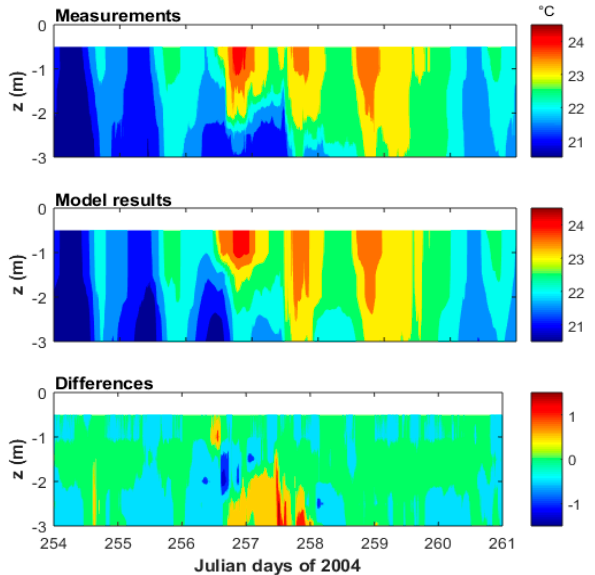
Figure 3. Measured and modelled water temperature time series at different depths at the central (CT) location. The lines with double arrows indicate the period of velocity measurements using ADCP.